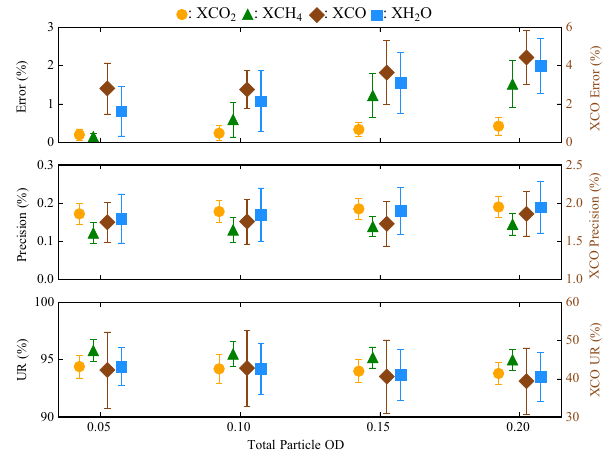
Figure 8. Average retrieval biases, precisions, and uncertainty re- ductions (UR) for simulated all-sky retrievals as a function of the total particle optical depth (OD) at 755nm. SNR is 300 and spec- tral resolution is 0.25cm − 1 . The a priori is biased 3% from the truth and has a 3% uncertainty. The error bars are the standard deviations of retrieval results from the test